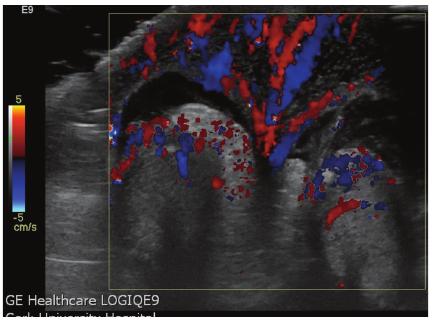
Figure 2: Transverse color Doppler image showing the “Fountain Sign” of increased blood flow in the edematous scrotal